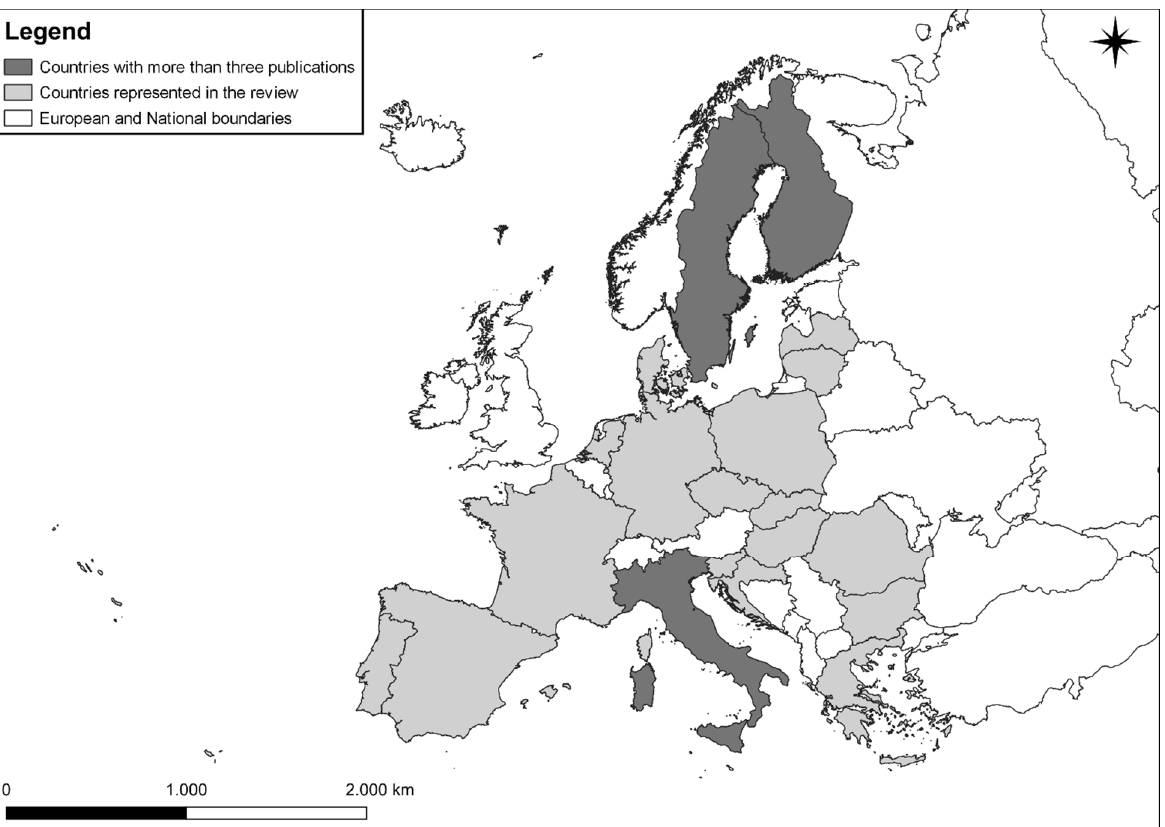
Figure 2. Countries represented in the review referring to the local perception of the involved categories (urban inhabitants, rural inhabitants, hunters, general public, conservationists). In Italy, we found five papers focused on the evaluation of stakeholders’ perception towards carnivores. In Sweden, ten scientific articles focused on stakeholders’ perception. As far as Finland is concerned, only four articles focusing on the attitude of stakeholders were found.